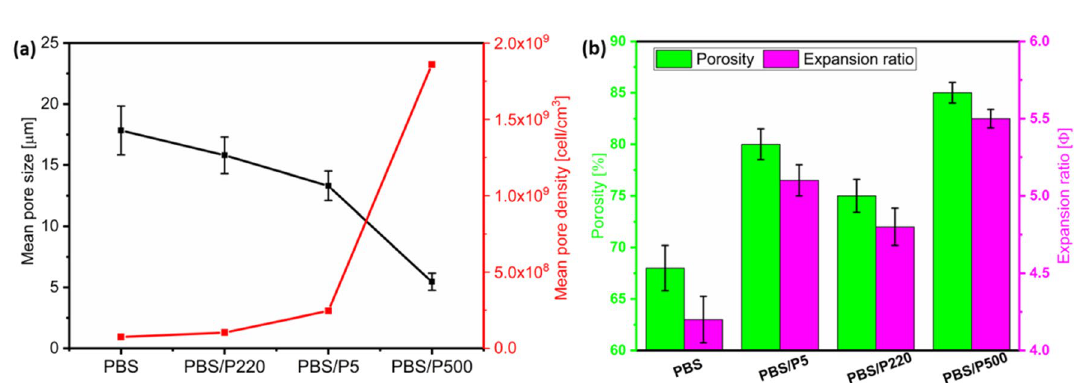
Figure 11. ( a ) Curves of mean pore size and pore density and ( b ) a histogram of the porosity and volume expansion ratio for PBS and the composite